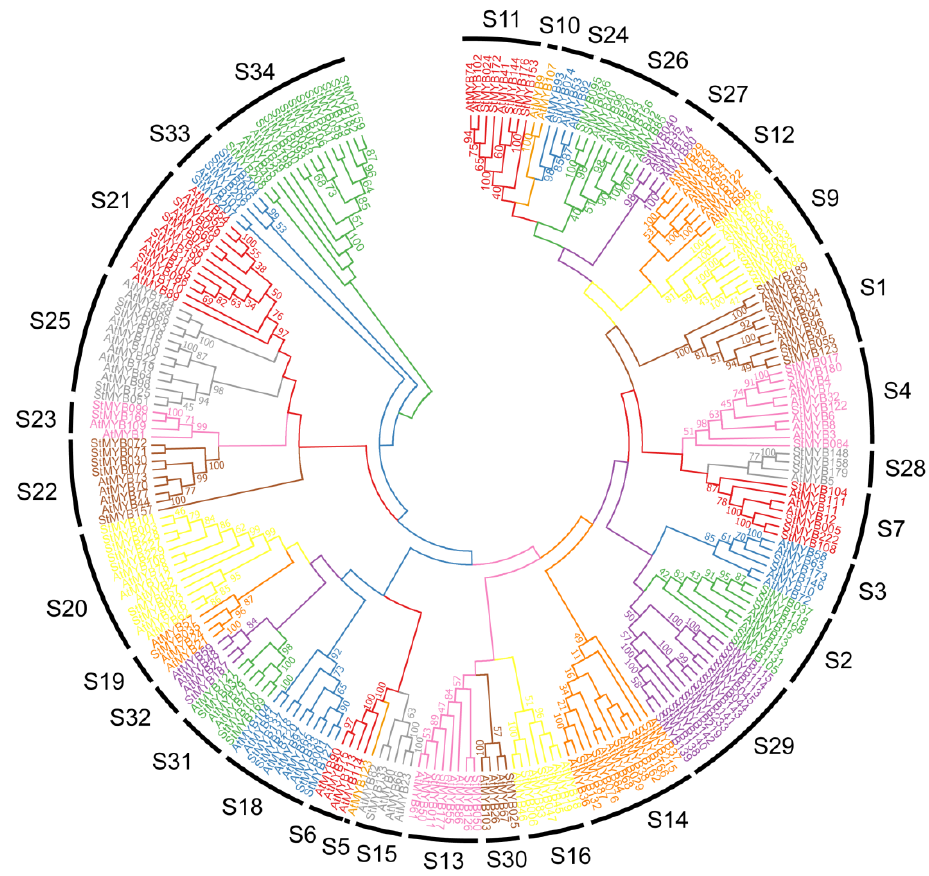
Figure 2. Phylogenetic analysis of potato R2R3-MYB family members. The phylogenetic tree was generated from the alignment of potato and Arabidopsis R2R3-MYB proteins with 1000 bootstrap replicates using the neighbor-joining (NJ) method. The potato R2R3-MYB members together with their Arabidopsis homologs were classified into 34 subgroups.